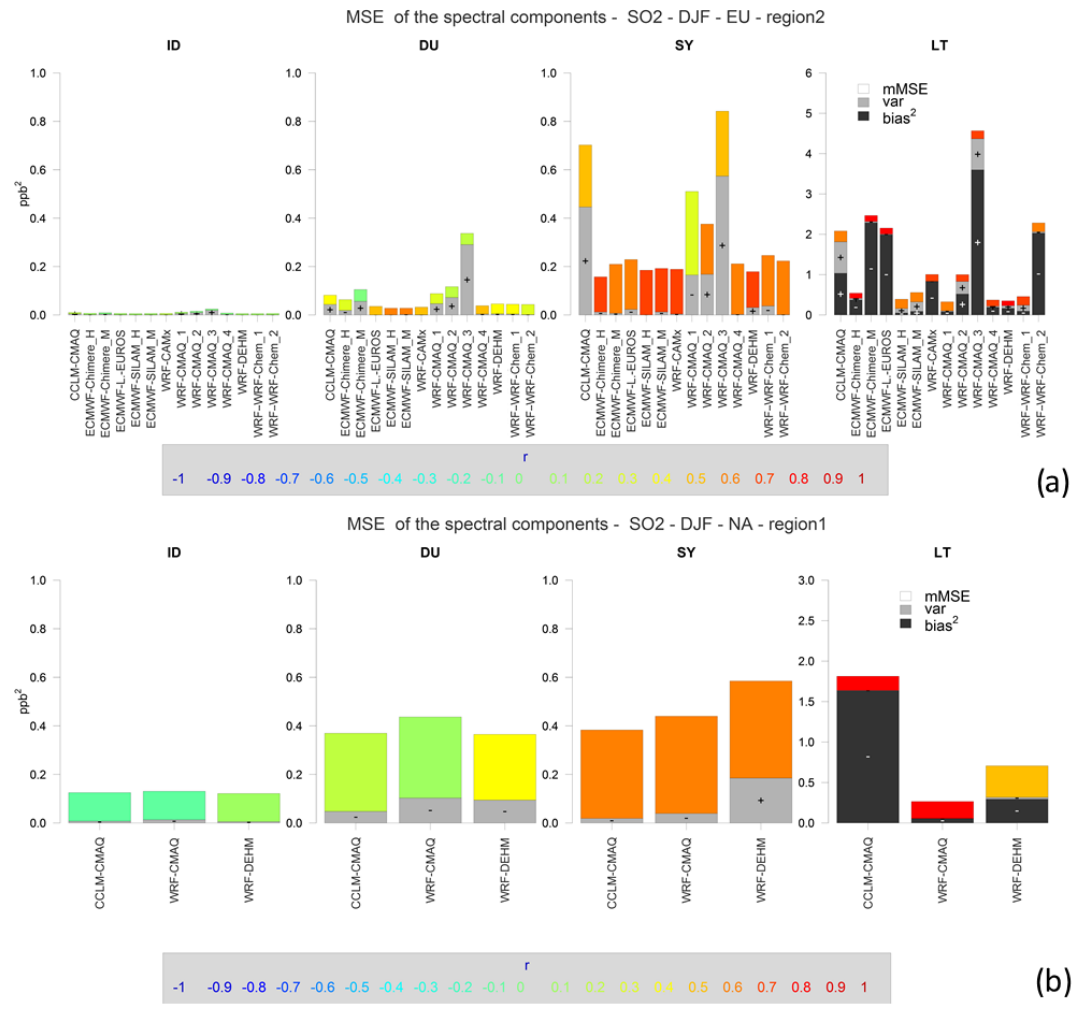
Figure 23. As in Fig. 10 but for SO 2